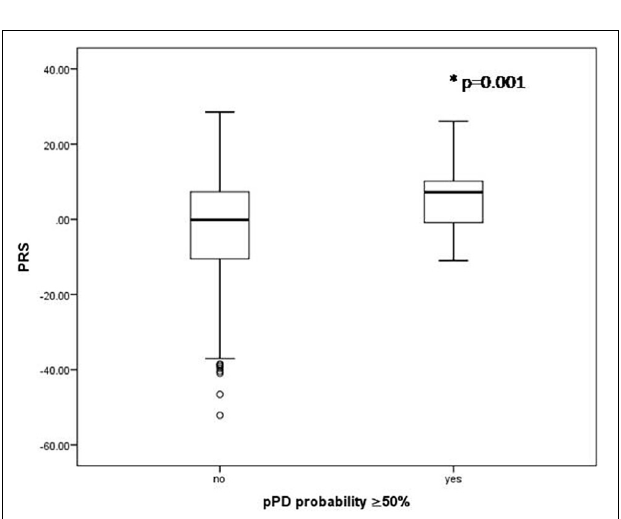
FIGURE 2 | Boxplots of PRS for those having or not 50% or more pPD probability. P -value derived from unpaired t